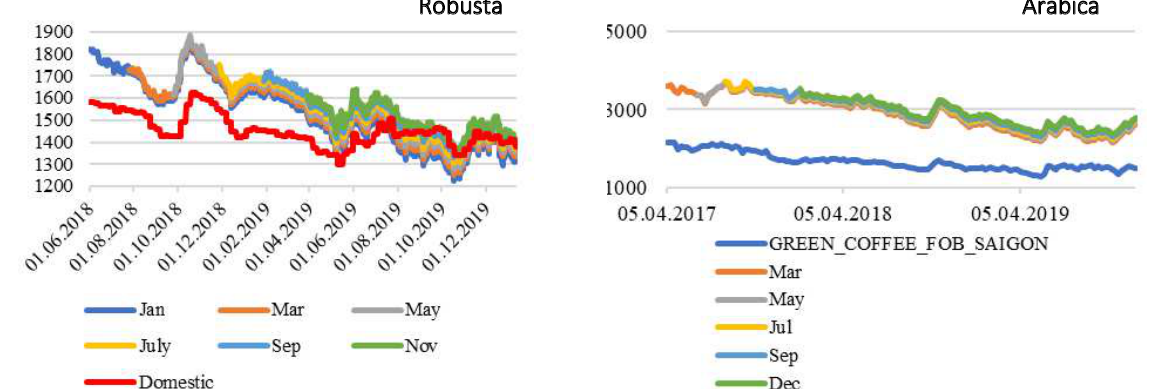
Figure 2. Movements of coffee spot prices in Vietnam and coffee futures prices on ICE EU and ICE US